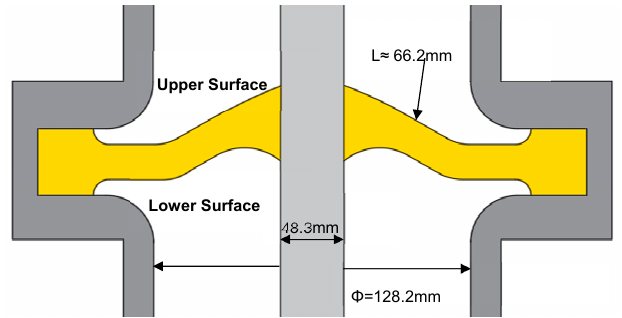
Figure 6. Optimized shape of the spacer model for DC energization.